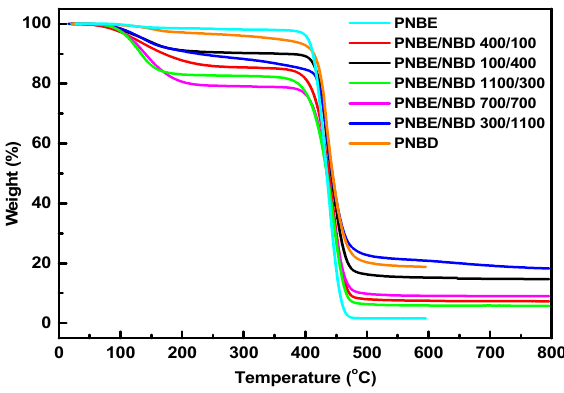
Figure 4. Weight loss (%) vs. temperature (°C) for all samples, as indicated.